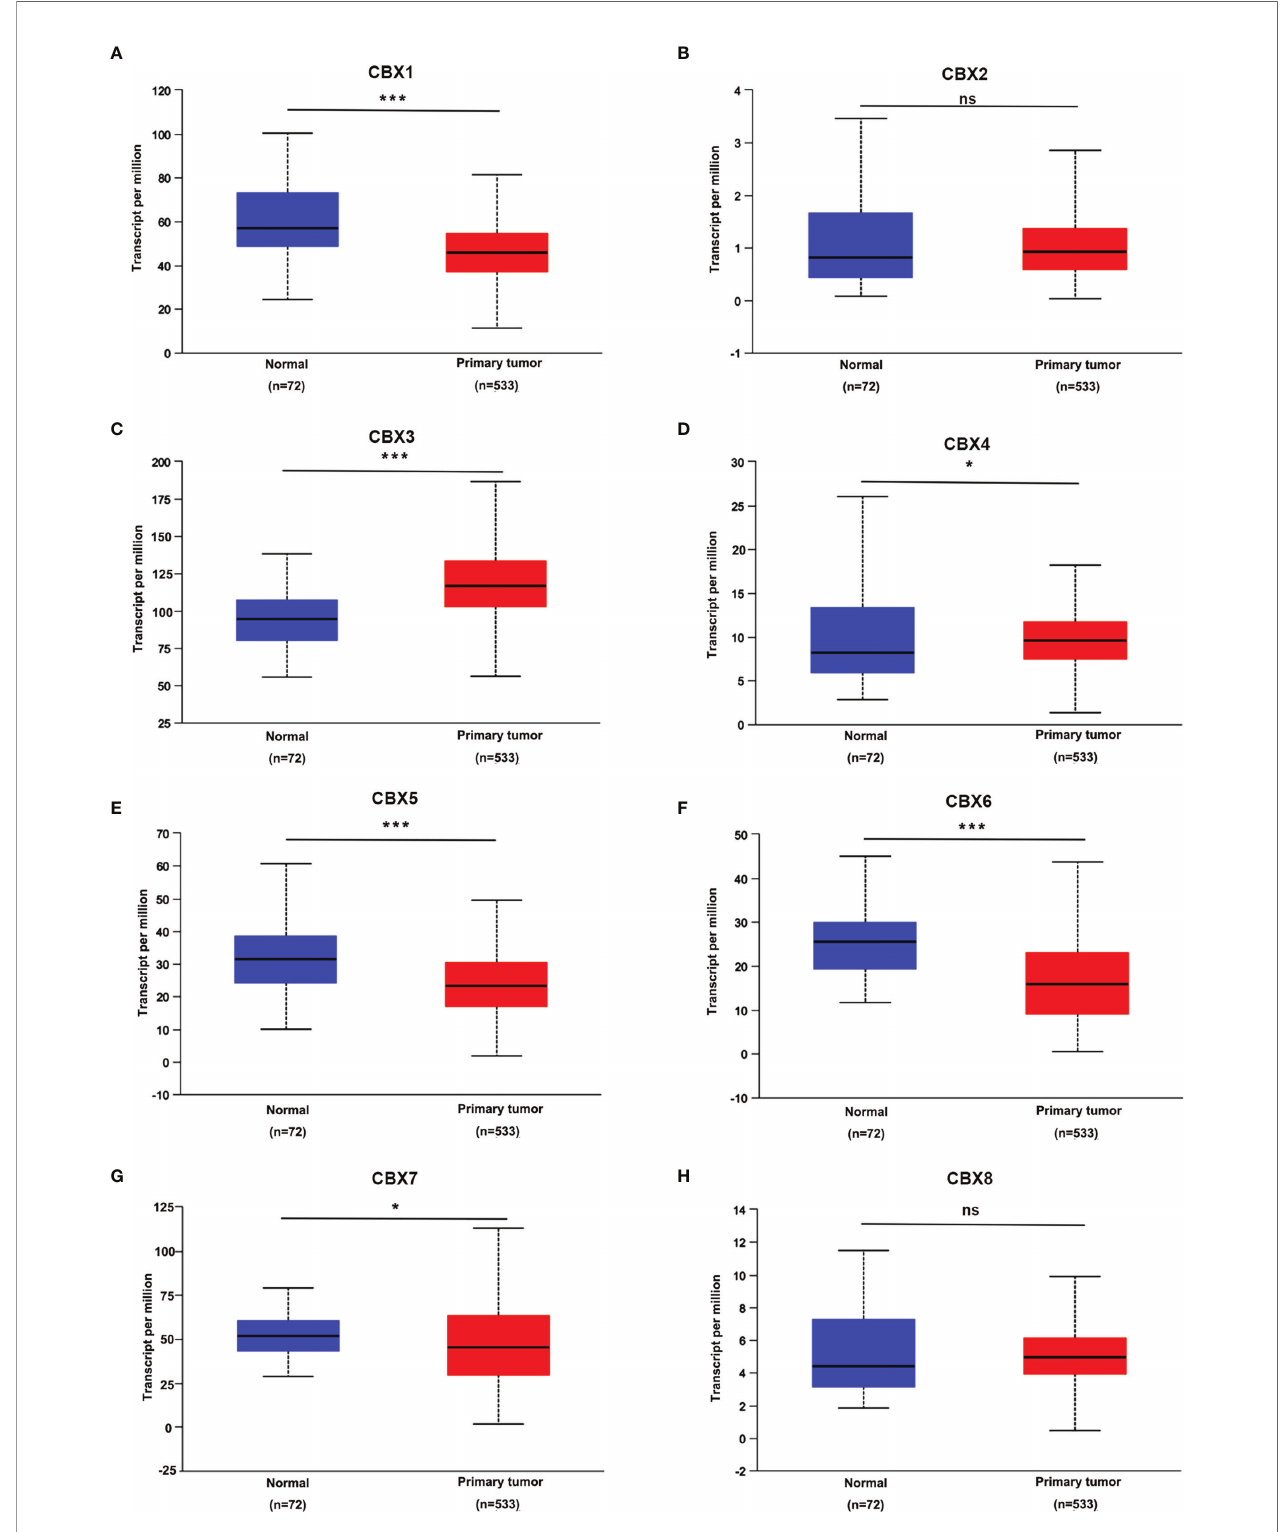
FIGURE 1 | The transcription levels of CBXs in ccRCC (UALCAN). The transcription levels of CBX3 and CBX4 in ccRCC tissues were signi fi cantly elevated compared with normal kidney tissues (C, D) , while the transcriptional levels of CBX1, CBX5, CBX6, CBX7 were signi fi cantly reduced in ccRCC tissues (A, E – G) . The CBX2 and CBX8 were expressed at similar levels in ccRCC tissues and normal kidney tissues (B, H) . (* p <0.05, *** p <0.001, ns: no signi fi